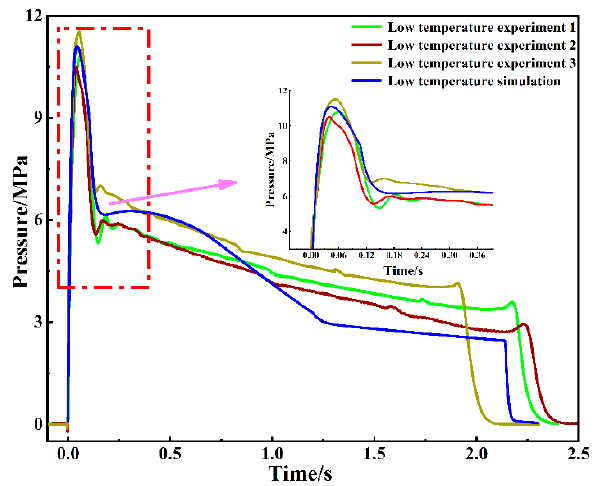
Figure 5. The experiment setup.